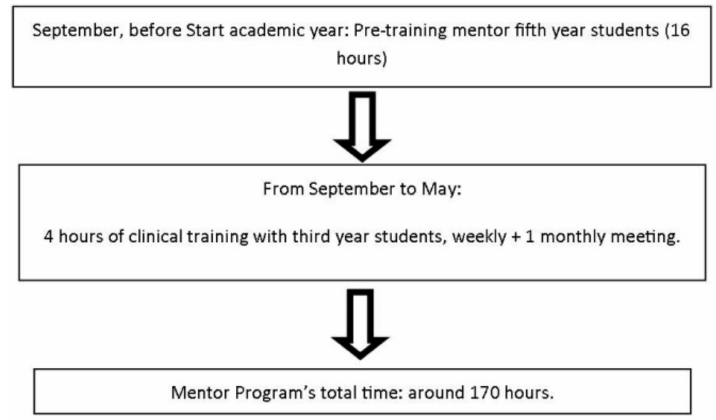
Figure 1. Mentor program framework.